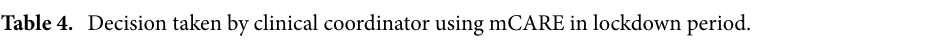
Table 4. Decision taken by clinical coordinator using mCARE in lockdown